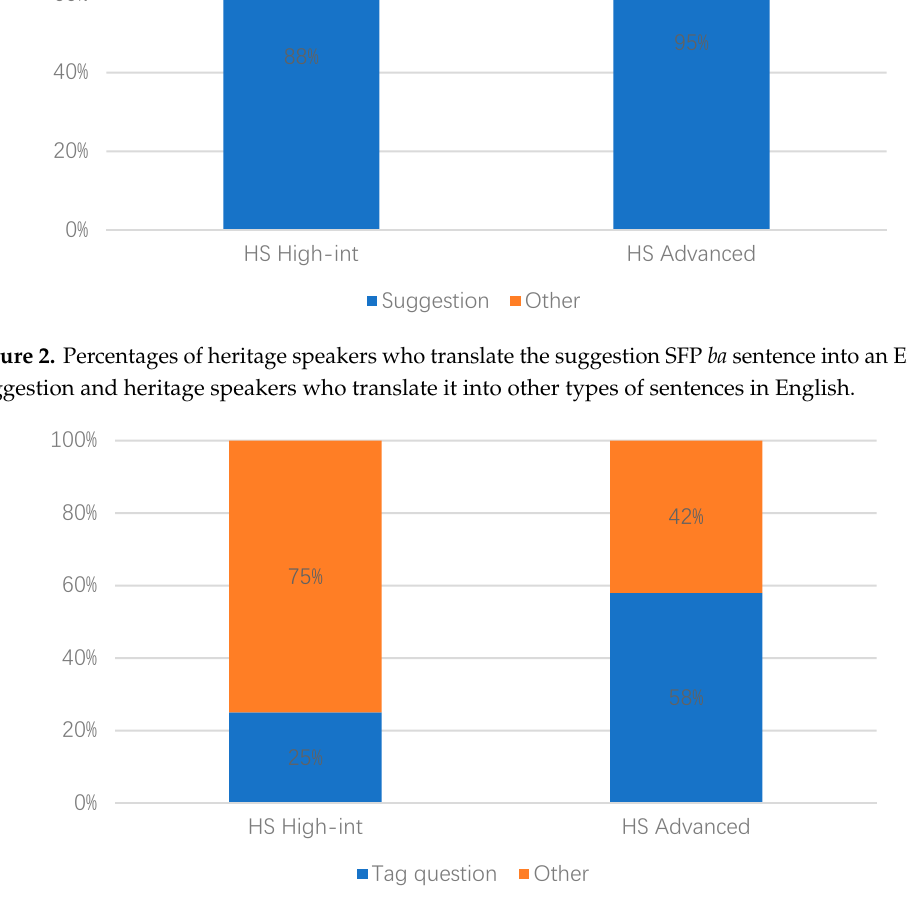
Figure 3. Percentages of heritage speakers who translate the question SFP ba sentence into an English tag question and heritage speakers who translate it into other types of sentences in English.